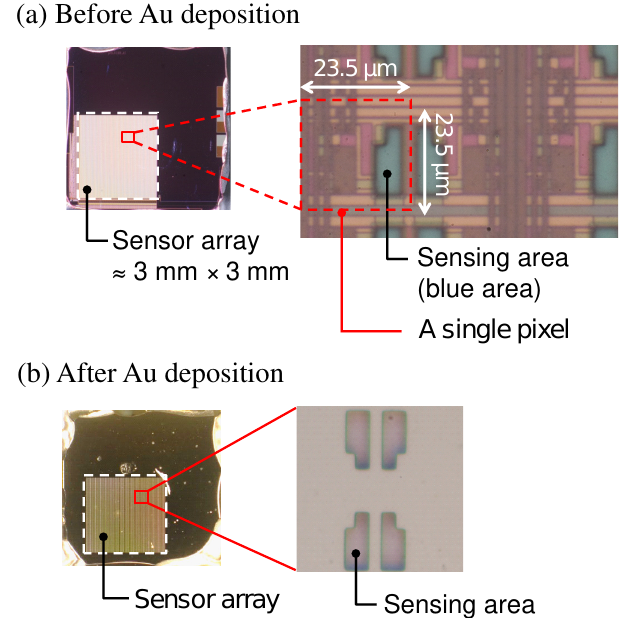
Figure 3. Picture of sensor chip ( a ) before and ( b ) after Au